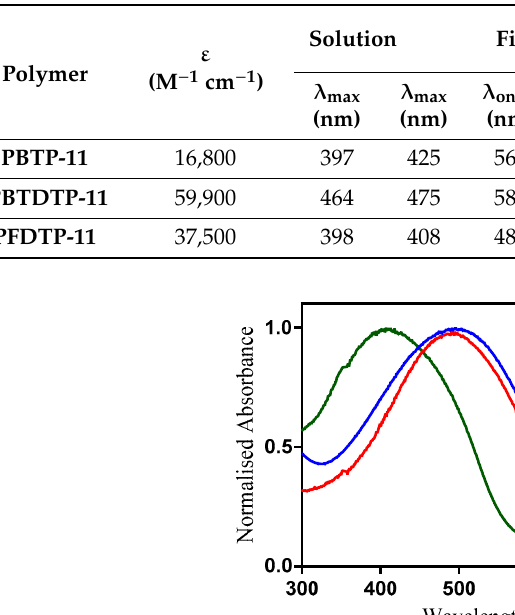
Figure1. NormalizedUV-visabsorptionspectraofPBTP-11, PBTDTP-11andPFDTP-11in( a )chloroform Figure 1. Normalized UV-vis absorption spectra of PBTP-11, PBTDTP-11and PFDTP-11 in ( a ) solutions; and ( b ) thin films. chloroform solutions; and ( b ) thin films . Table 2. Data and optical band gaps of the polymers.